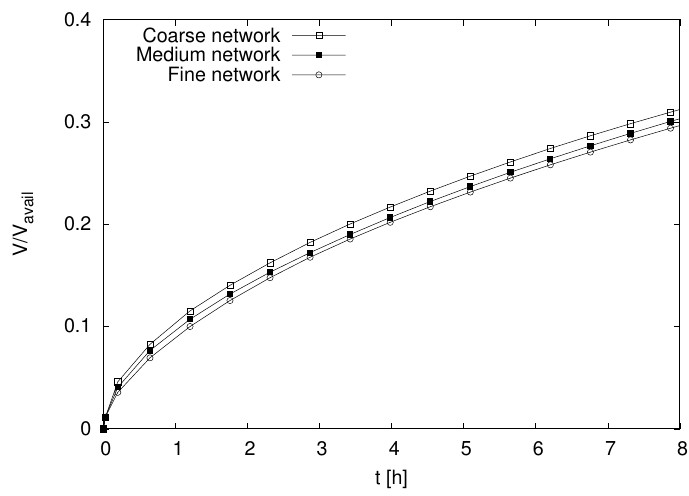
Figure 13. Influence of element size on the cumulative volume of inflow normalised by the domain volume.